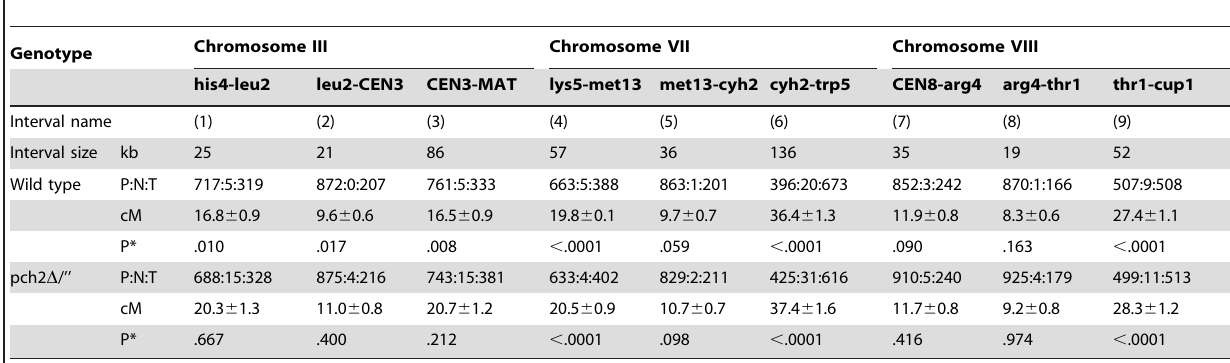
Table 1. Effects of pch2 D on genetic distances and crossover interference in intervals along three chromosomes at 33 u